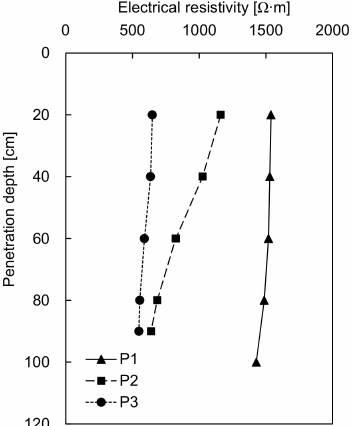
Figure 11. Profiles of electrical resistivity estimated at the three different locations.